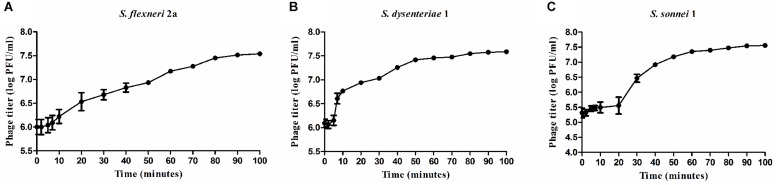
One step growth curve of bacteriophage Sfin-1. Shigella flexneri 2a, Shigella dysenteriae 1, Shigella sonnei were infected with Sfin-1 at 37°C at an MOI of 0.01. After phage absorption, the cultures were diluted 104-fold, incubated at 37°C and the titers in PFU per mL of Sfin-1 from the infected cultures at different time points were determined. Result was plotted as mean ± SD (n = 3). (A–C) Present one step growth curves of Sfin-1 in Shigella flexneri 2a, Shigella dysenteriae 1, and Shigella sonnei, respectively.